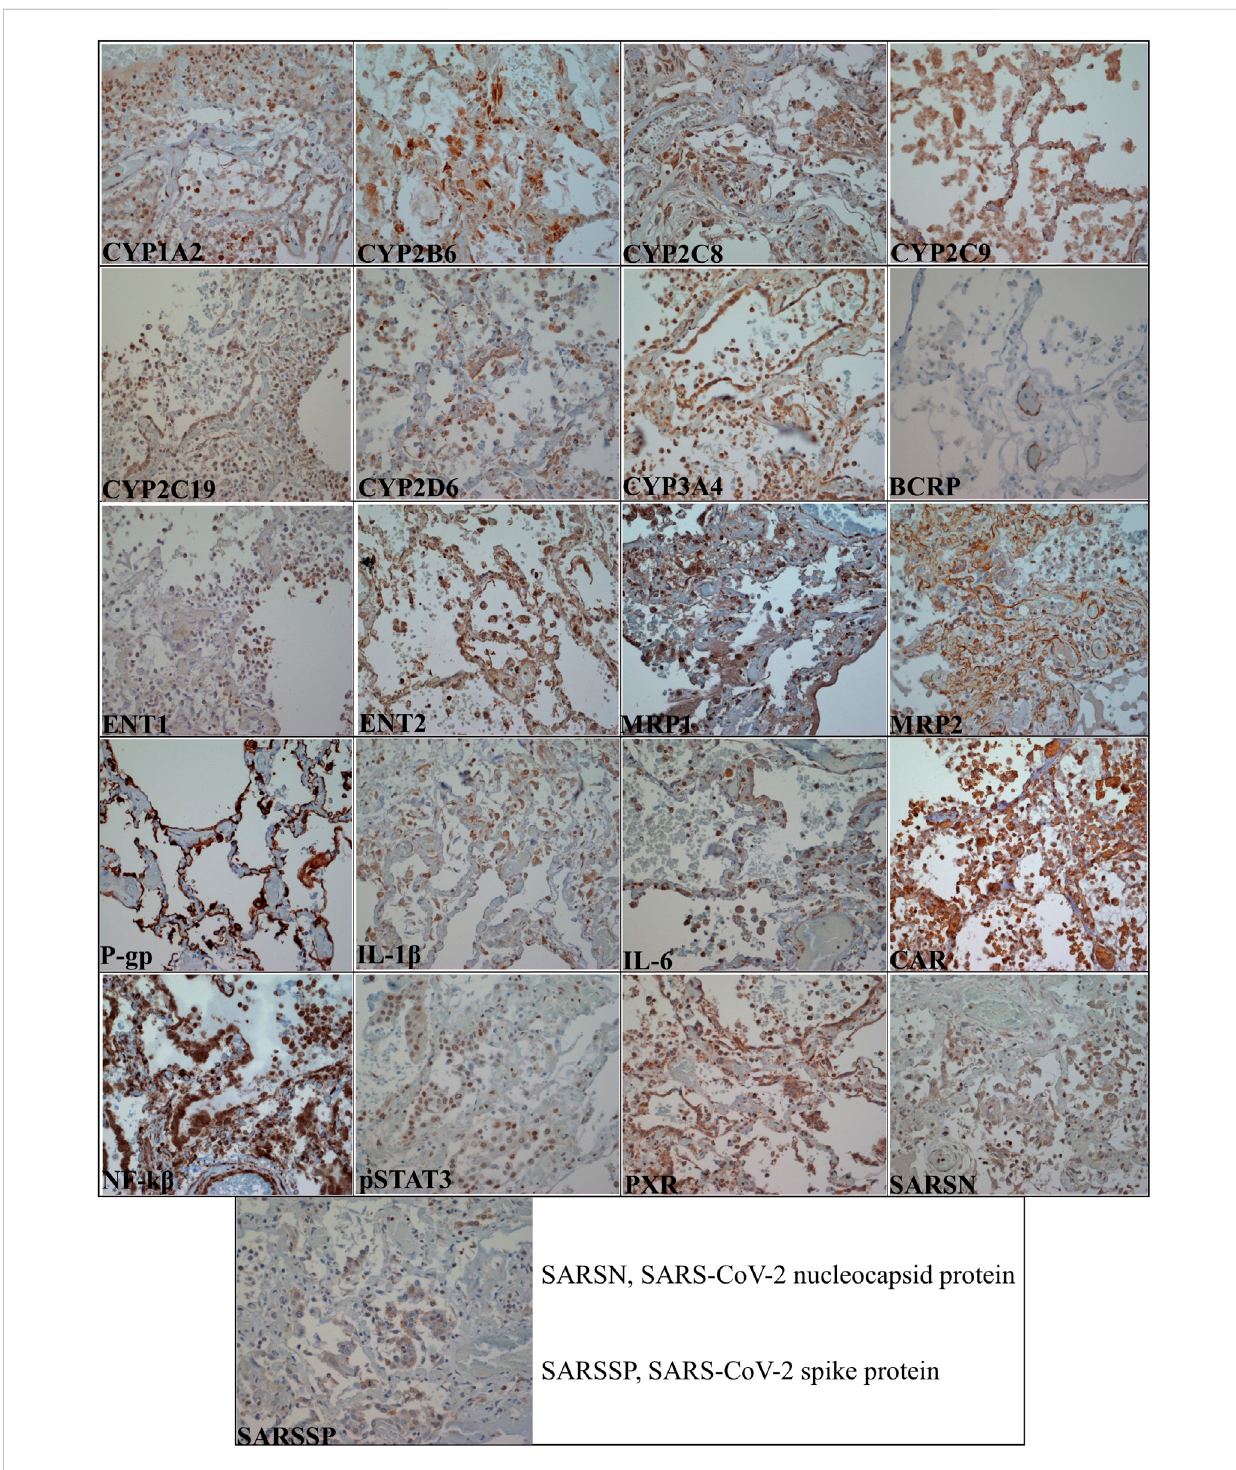
FIGURE 4 Micrographs of COVID-19 postmortem human lung tissue sections (×40 magni fi cation with an Olympus B×43 microscope) showing positive staining in brown color for all the investigated biomarkers. Table 2 summarizes the pulmonary cellular localization of the investigated